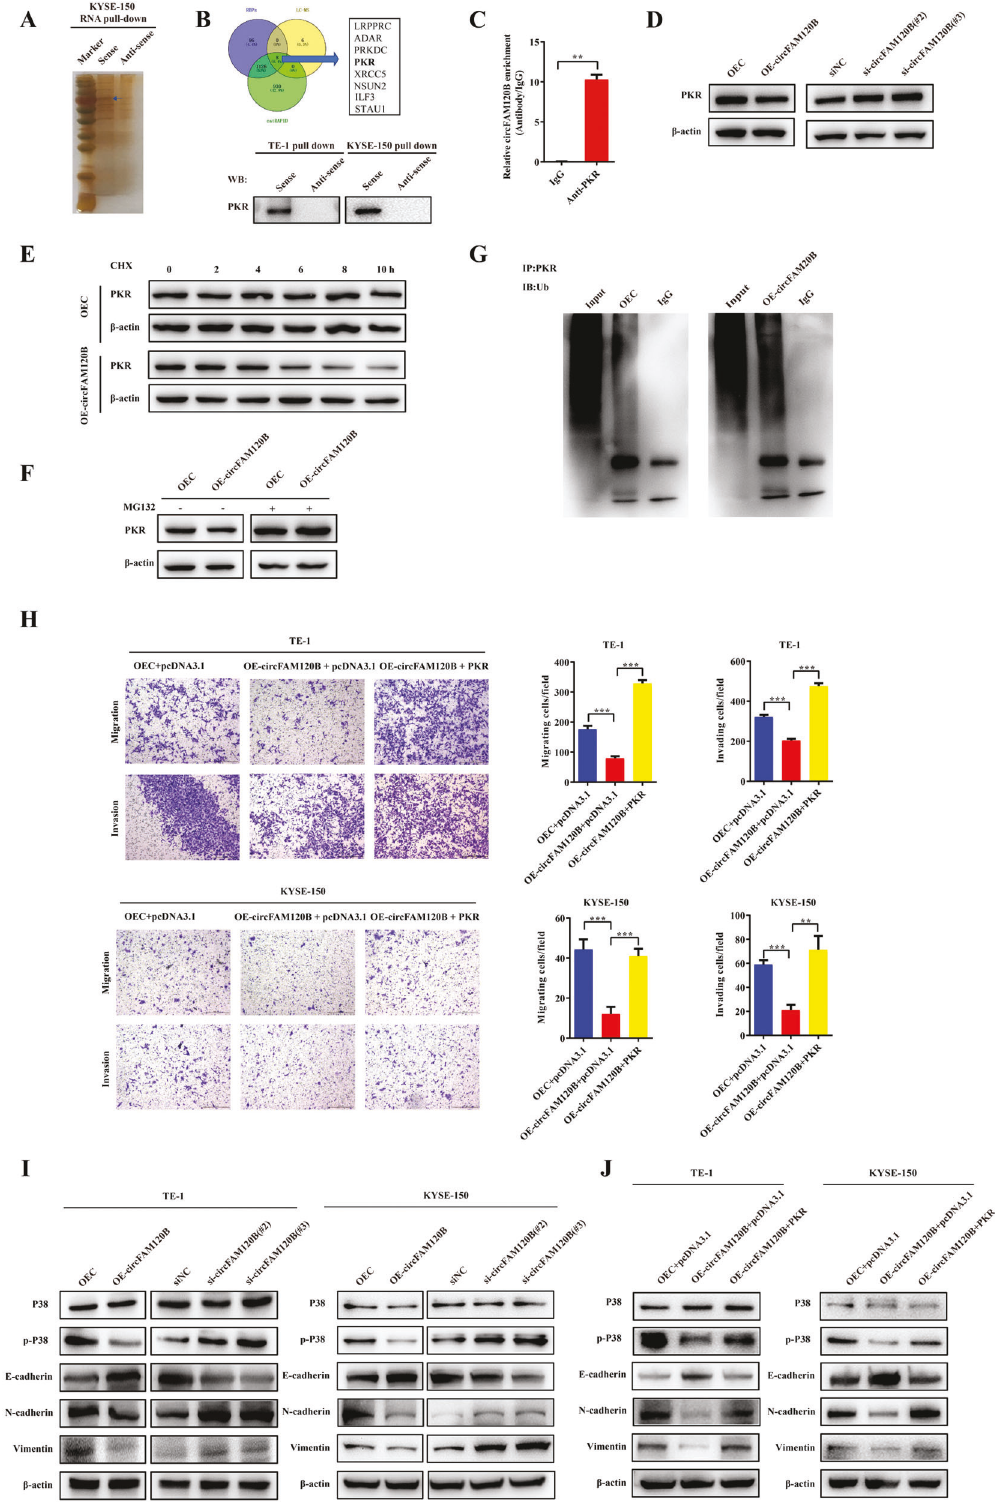
of circFAM120B and PPM1L in ESCC, we examined their levels in 96 ESCC patients and found that the expression of PPM1L was lower in ESCC tissues than in adjacent normal-appearing tissues in ESCC (Fig. 6F). The expression of PPM1L was positively correlated Cell Death and Disease (2022)